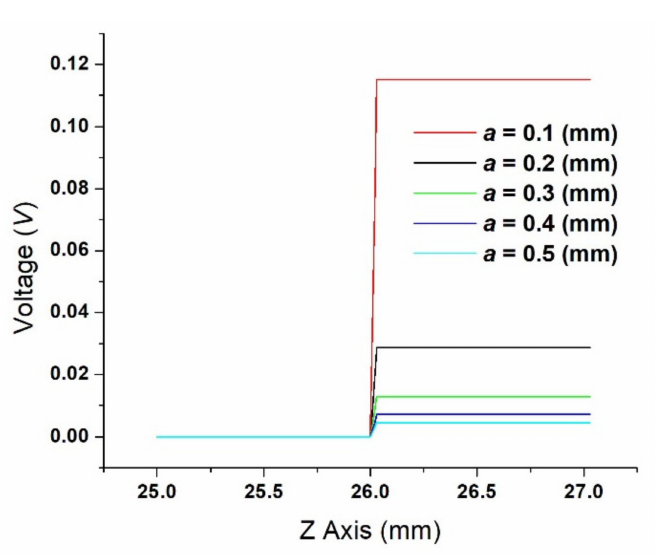
Figure 9. Computed voltage for contact spot radius of 0.1 mm: ( a ) two-dimensional view and ( b ) three-dimensional view.